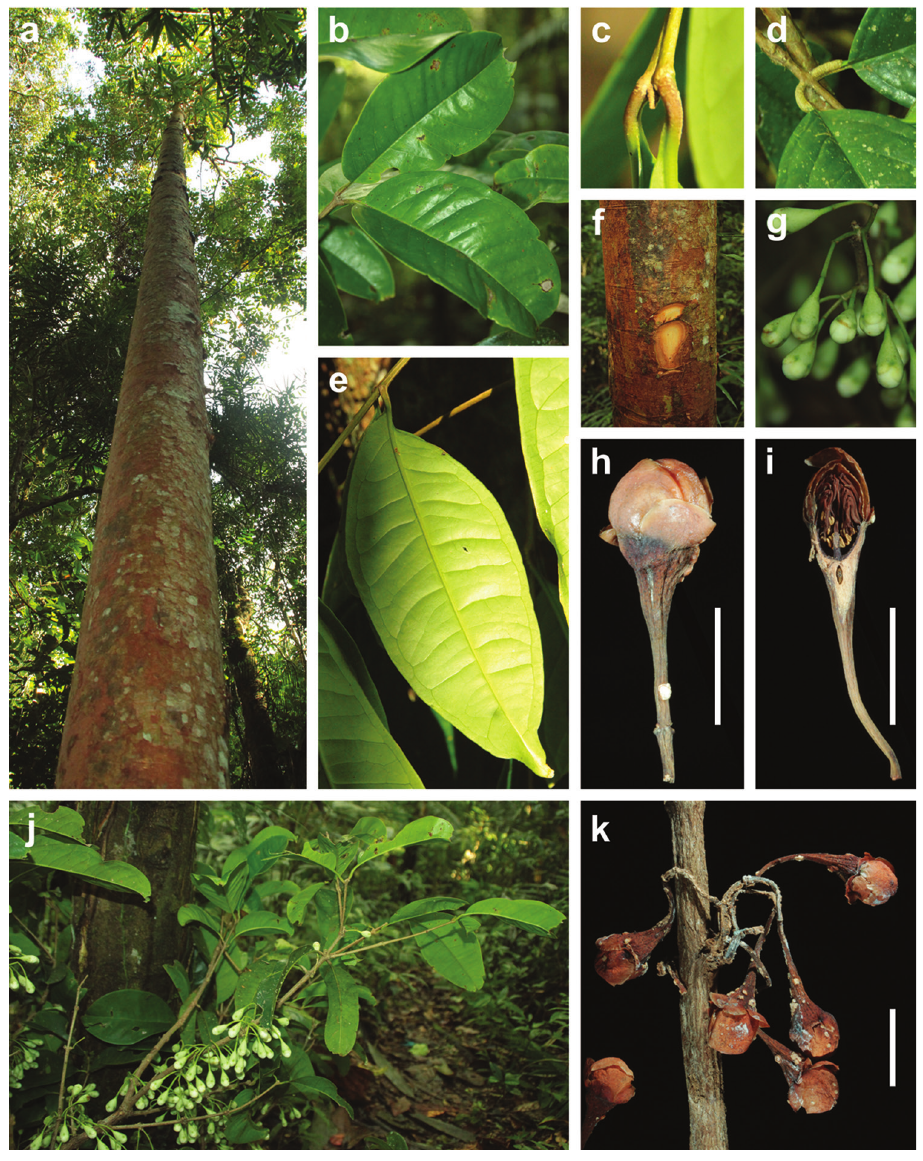
Figure 7. Morphological characters of Syzygium galanthum . a trunk, c. 15 m tall b upper side of leaves c branchlet tip with smooth younger petioles d older corky petioles e underside of leaf f bark slash g ma- ture flower buds in fresh state h dried mature flower bud with apical part of inflorescence axis and white blister on the anthopodium i longitudinal section of mature flower bud in dried state j branch with mature flower buds below the leaves k detail of dried, fascicled inflorescences. a–b and f–k type collection Bram- bach et al. 1316 c and e Brambach et al. 1083 d Brambach et al. 1047 . All scale bars: 1